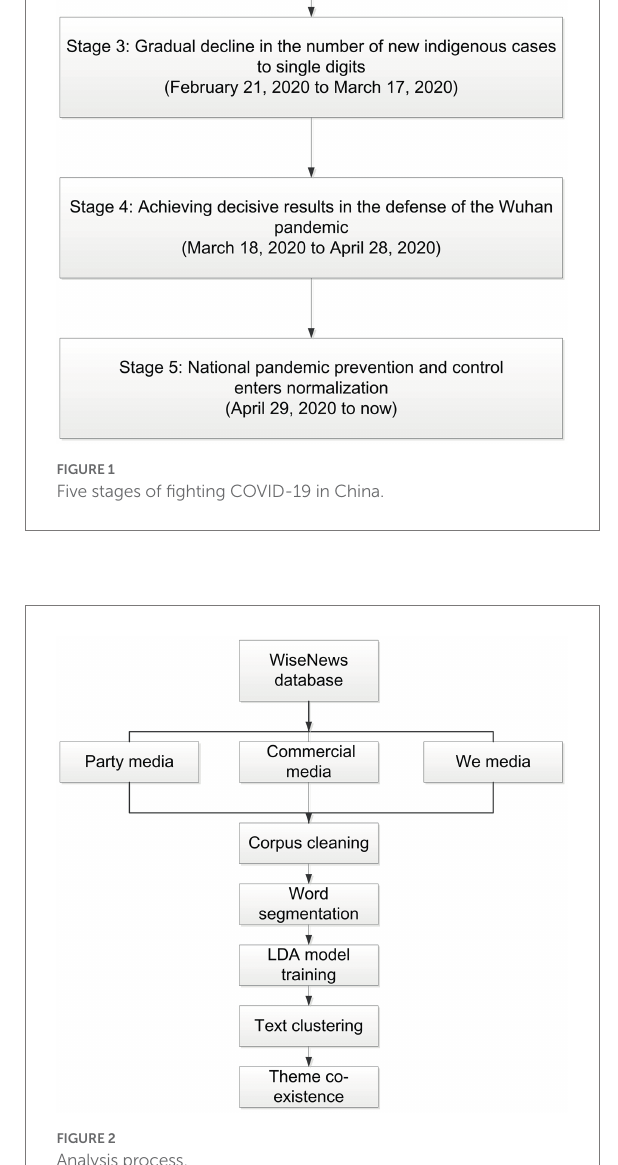
FIGURE 2 Analysis